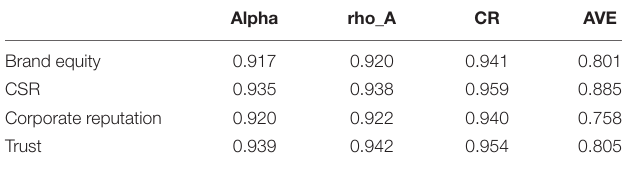
TABLE 1 | Construct reliability and